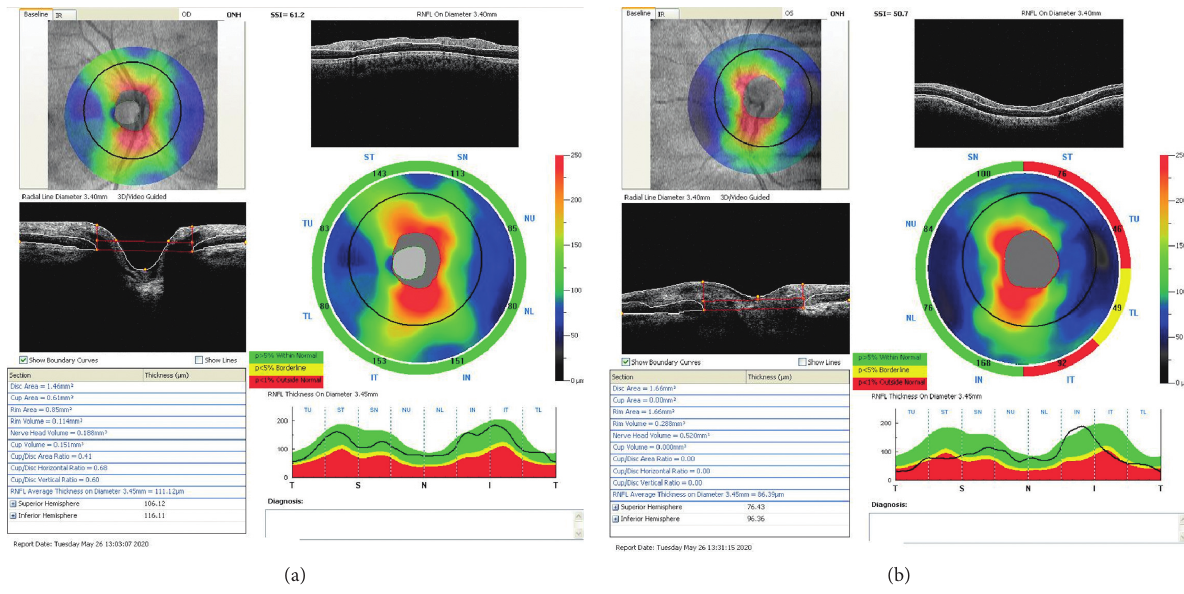
Figure 2: : Examples of OCTmeasurements of IIH and control patient matched by age. (a) Right eye RNFL measurement of an individual of the control group, 29-year-old patient, with RNFL average thickness on diameter 3.45mm � 111.12 μ m. (b) Left eye RNFL measurement of